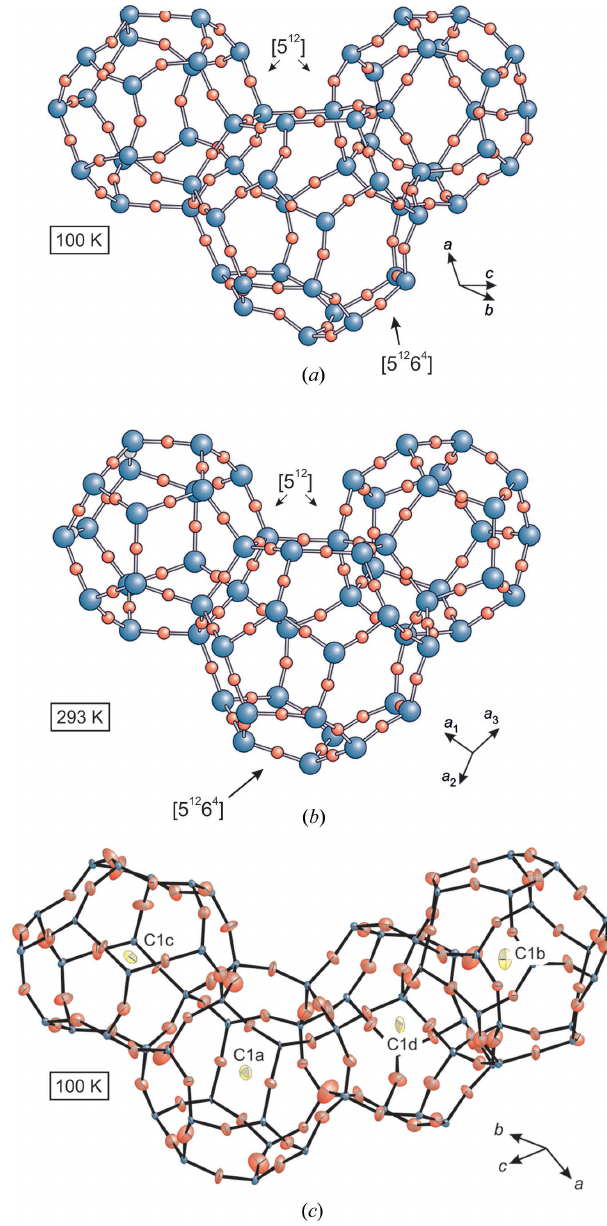
Figure 7 Comparison of the [5 12 ]- and [5 12 6 4 ]-type cages at ( a ) T = 100 K ( A 2/ n ), and ( b ) 293 K ( Fd 3 m ). Small red spheres represent the O atoms, and the large blue spheres are the Si atoms. Several Si—O—Si angles bend significantly in the LT form (100 K) in comparison with that at RT (293 K). ( c ) The four crystallographically different [5 12 ]-type cages (100 K, A 2/ n ), interconnected by sharing common five-membered ring units; the symmetry-released C1 atoms (labeled C1a, C1b, C1c, C1d) are located in the cage centers. All atoms are shown as 50% probability ellipsoids recalculated from the corresponding U ij values. As a result of the strong bending of the Si—O—Si bond angles, the individual cages are subject to significant distortions at LT and the deviation from the (average) Fd 3 m symmetry is evident. to C1d), and a total of 12 C2 positions are located inside the [5 12 6 4 ] cage (labeled C2a to C2l) (Fig. 8). The four C1 sites correspond to the four individual [5 12 ] cage centers, each located either on an inversion center or on a twofold axis.